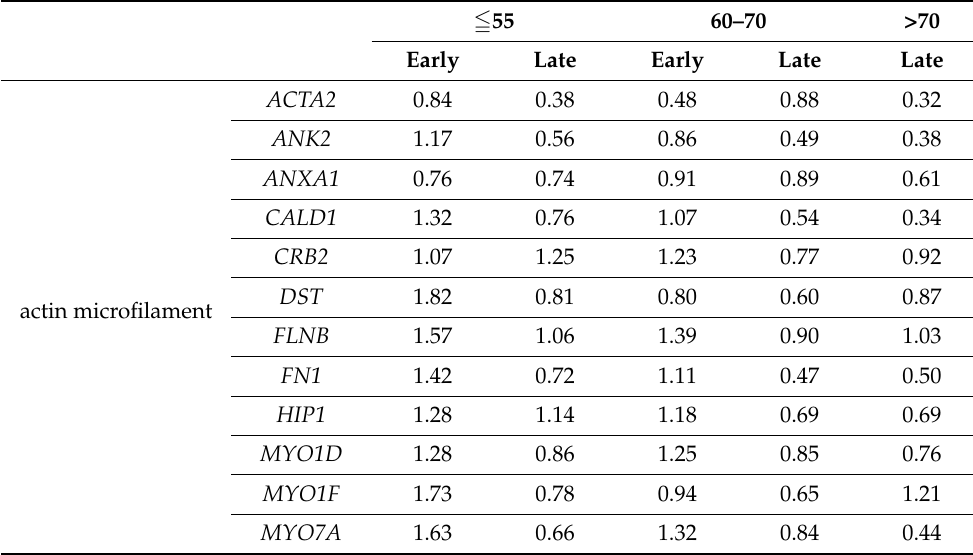
Table 6. The complementary data underlying networks in Figure 4 presenting expression profiles of the most essential invasion-related molecules that reflect the DFS prognosis according to the specific Notch signature. The values represent fold changes (FC) between unfavorable vs. favorable prognosis according to the specified Notch